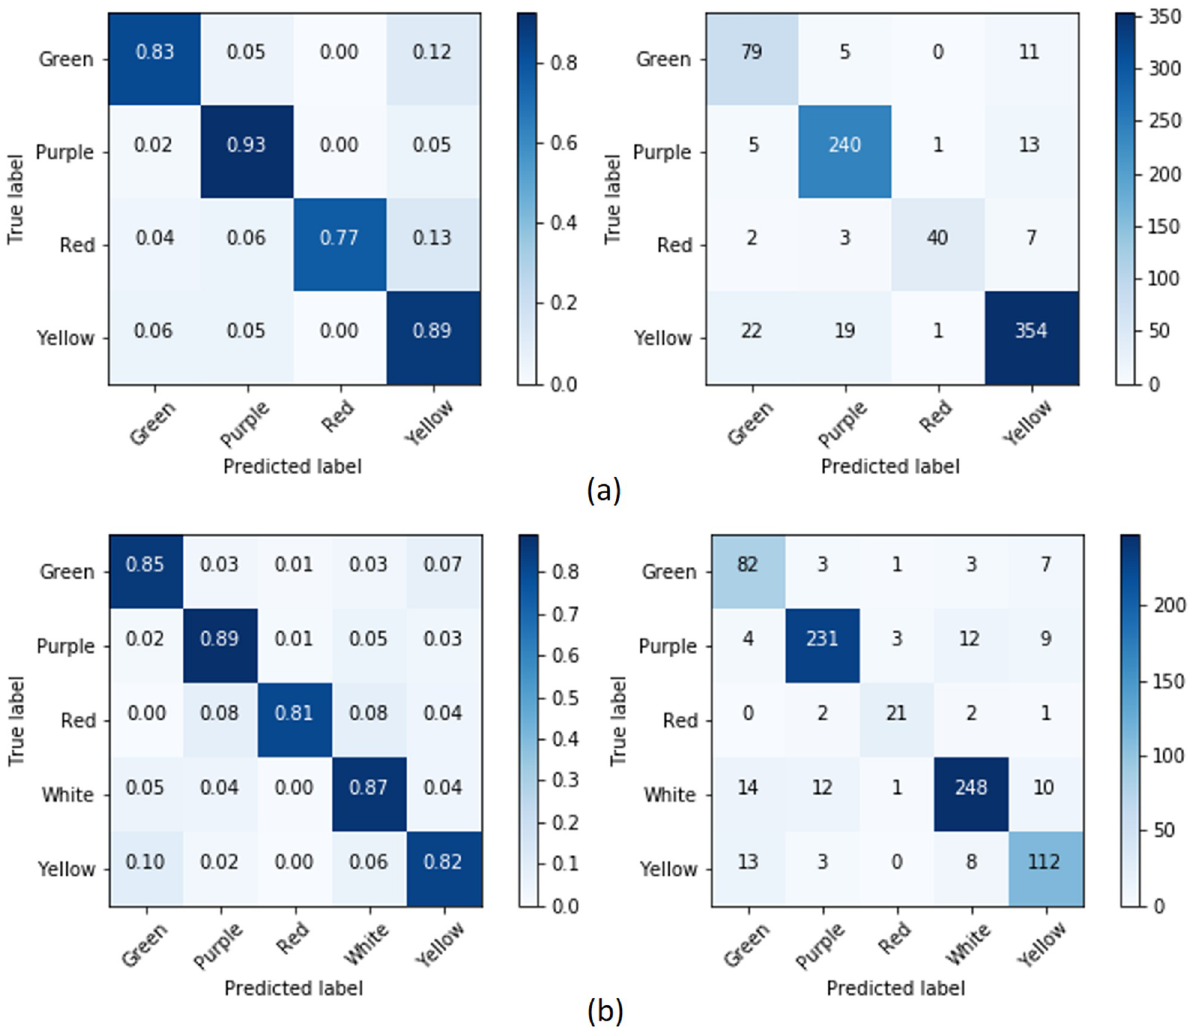
Fig 11. The confusion matrices for primary color: (a) CL1 and (b) CL2 using the ensemble classifier.